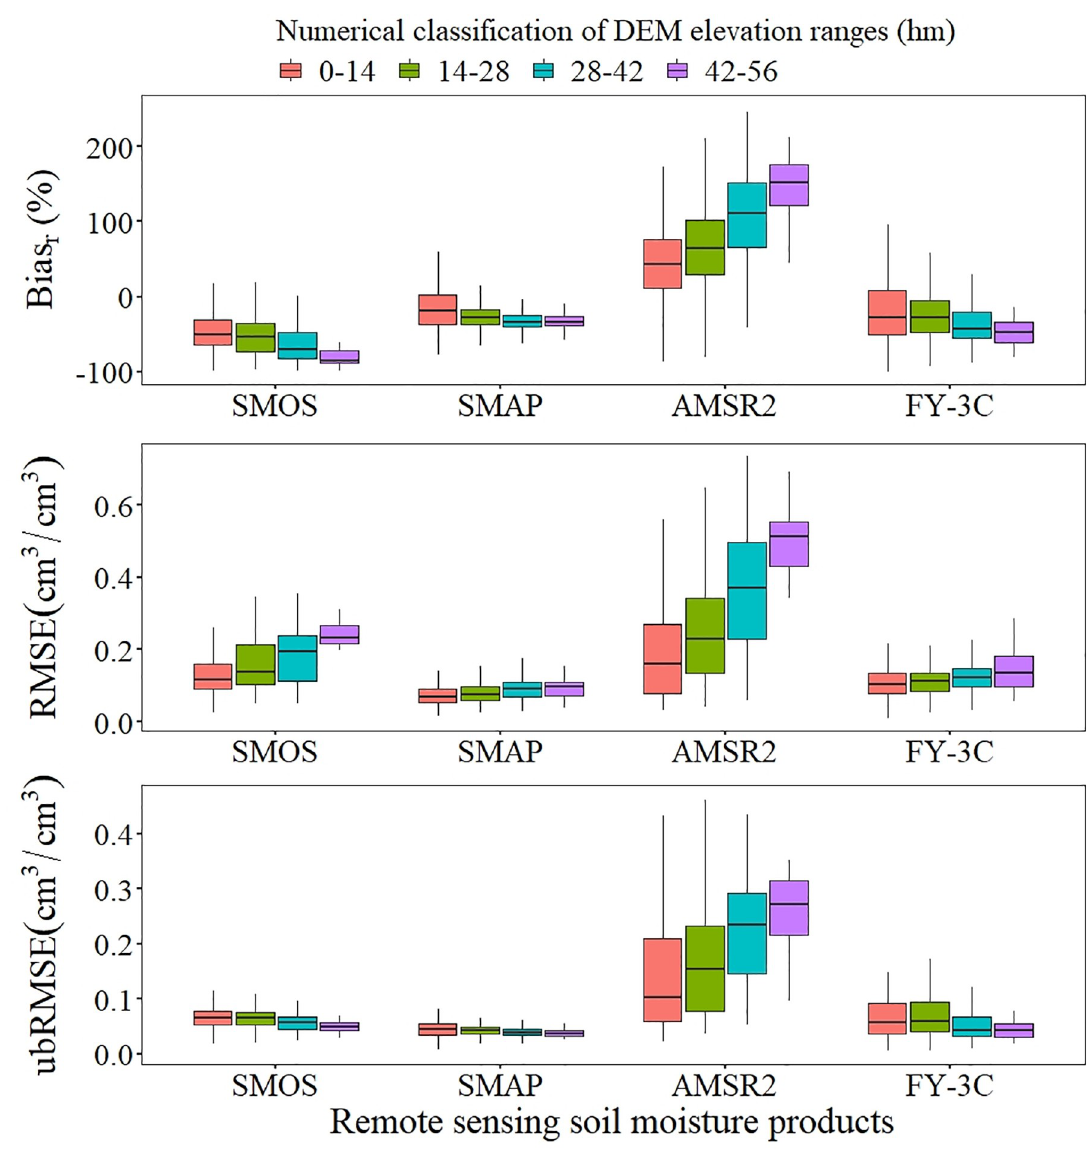
Fig 3. Boxplots of DEM elevation ranges for Bias r , RMSE and ubRMSE.